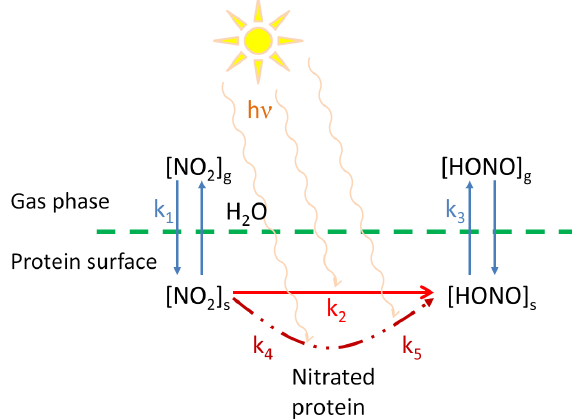
Figure 9. Schematic illustration of the underlying Langmuir– Hinshelwood mechanism of light-induced HONO formation on pro- tein surface. Reaction constants for NO 2 uptake, direct NO 2 con- version, protein nitration, HONO formation from decomposing ni- trated proteins and HONO release are indicated by k 1 , k 2 , k 4 , k 5 , and k 3